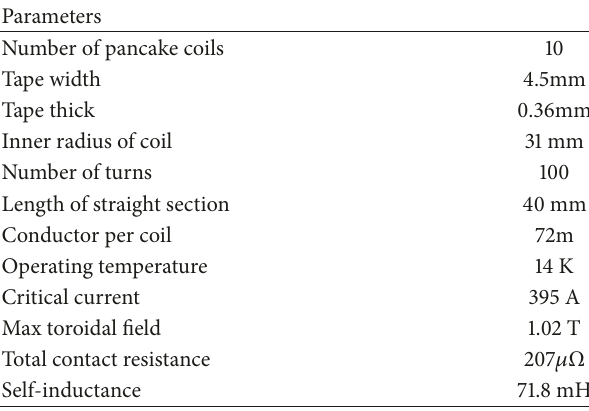
Table 1: Main parameters of the toroidal